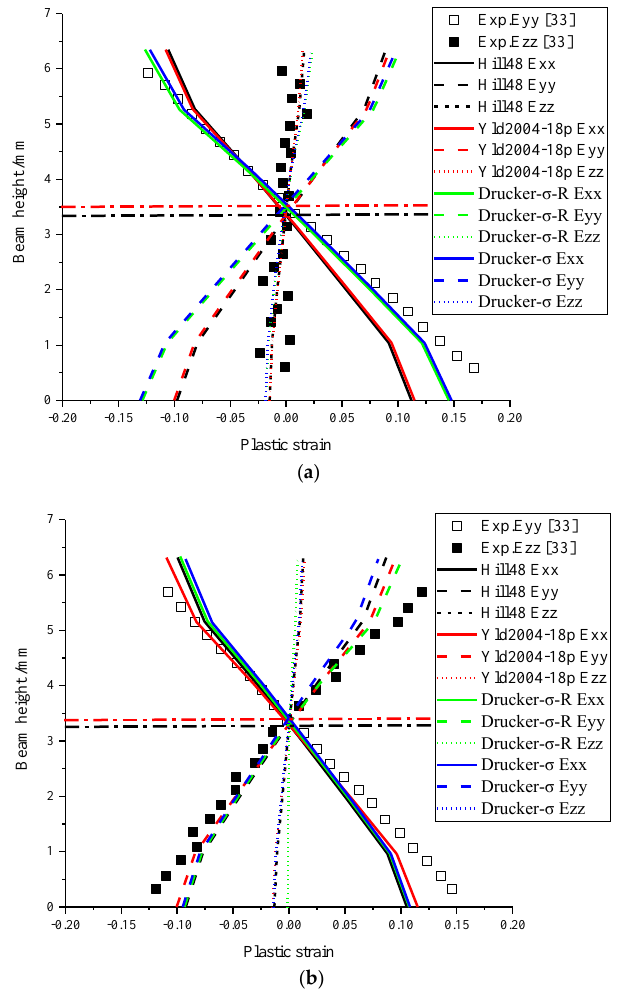
Figure 18. Strain distributions along the z -axis in the plane of the central cross-section simulated with different yield criteria and compared with observed data for the Zirconium plate: ( a ) TTB case and ( b ) IPB case (black dash-dot lines represent mid-surface for yield functions not considering SDE, while the red implies shift of mid-surface for yield functions considering SDE).